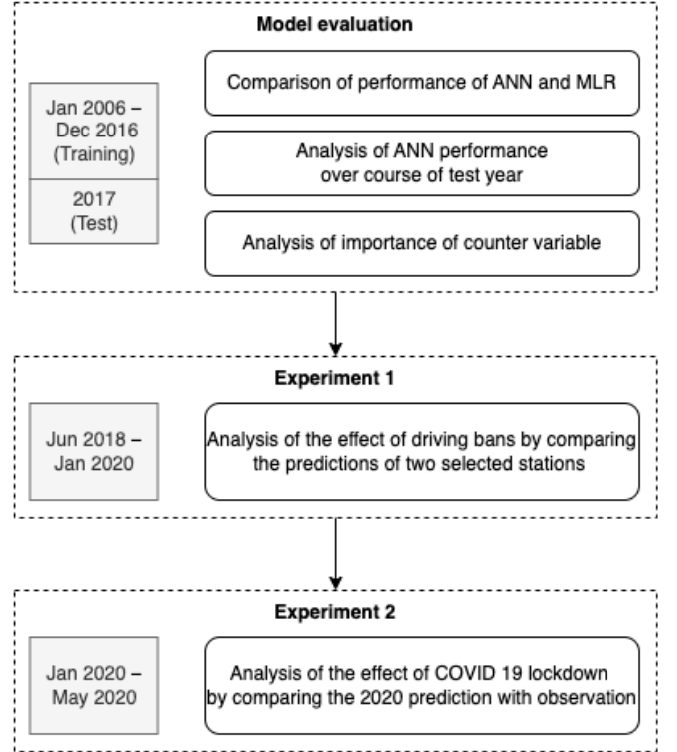
Figure 1. Workflow including the steps and respective time period